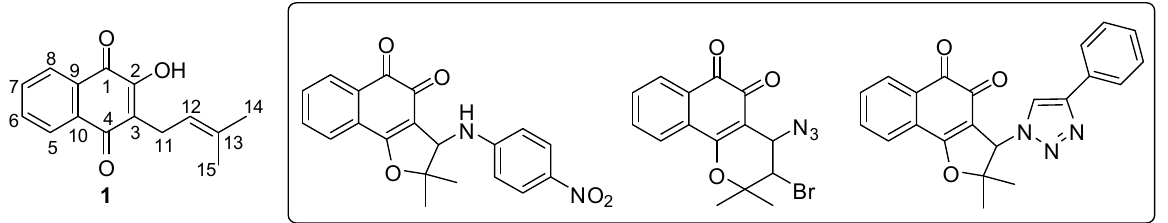
Figure 1. Structure of lapachol ( 1 ) and lapachone